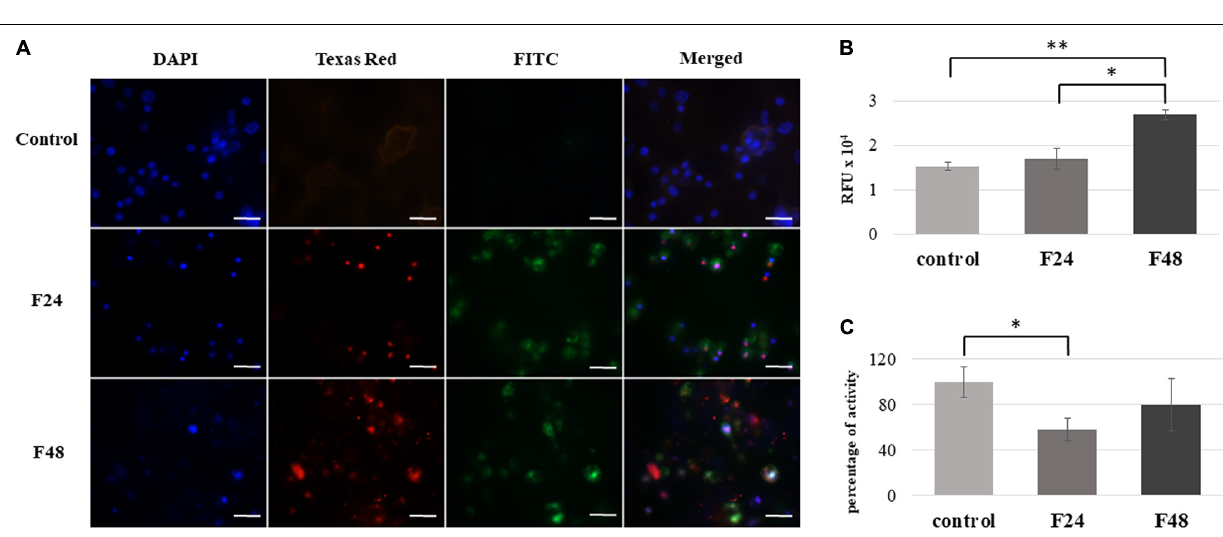
exact numerical data of the eicosanoid concentration are given in the Supplementary Table S1